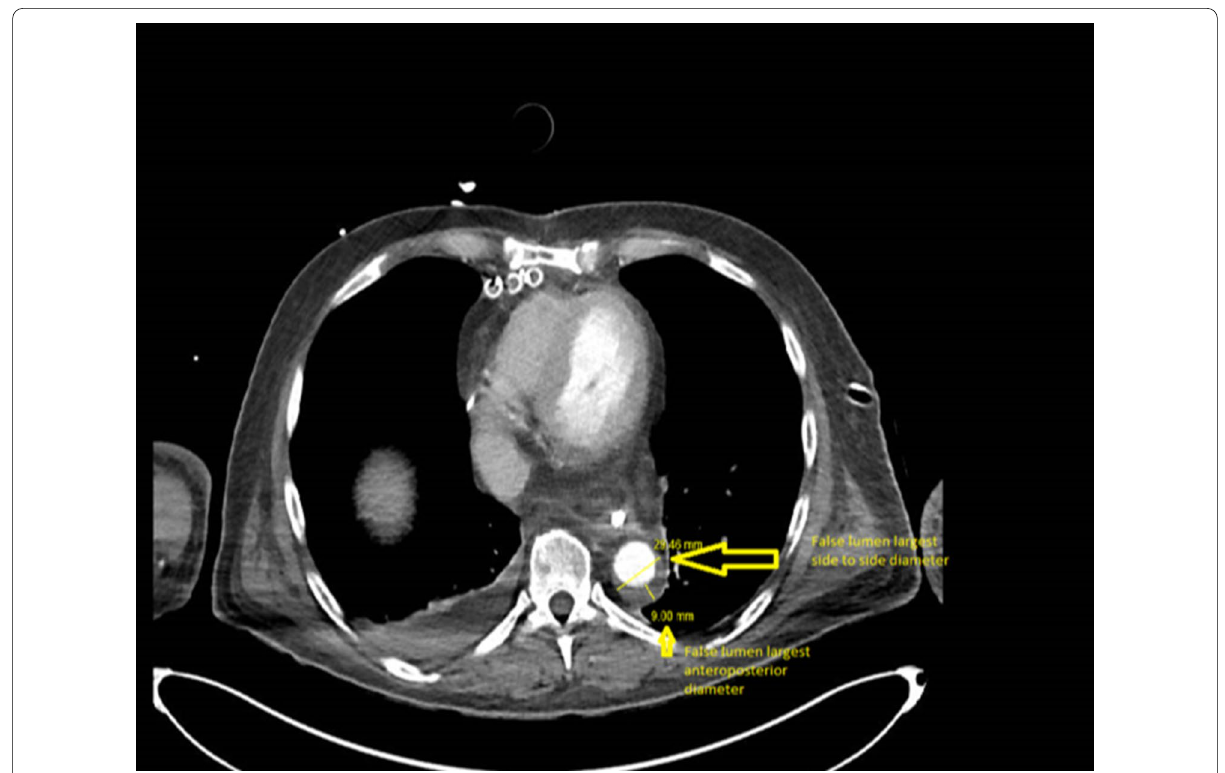
Fig. 2 Multislice computed tomography showing false lumen largest anteroposterior and side to side diameters at the level of the right diaphragmatic